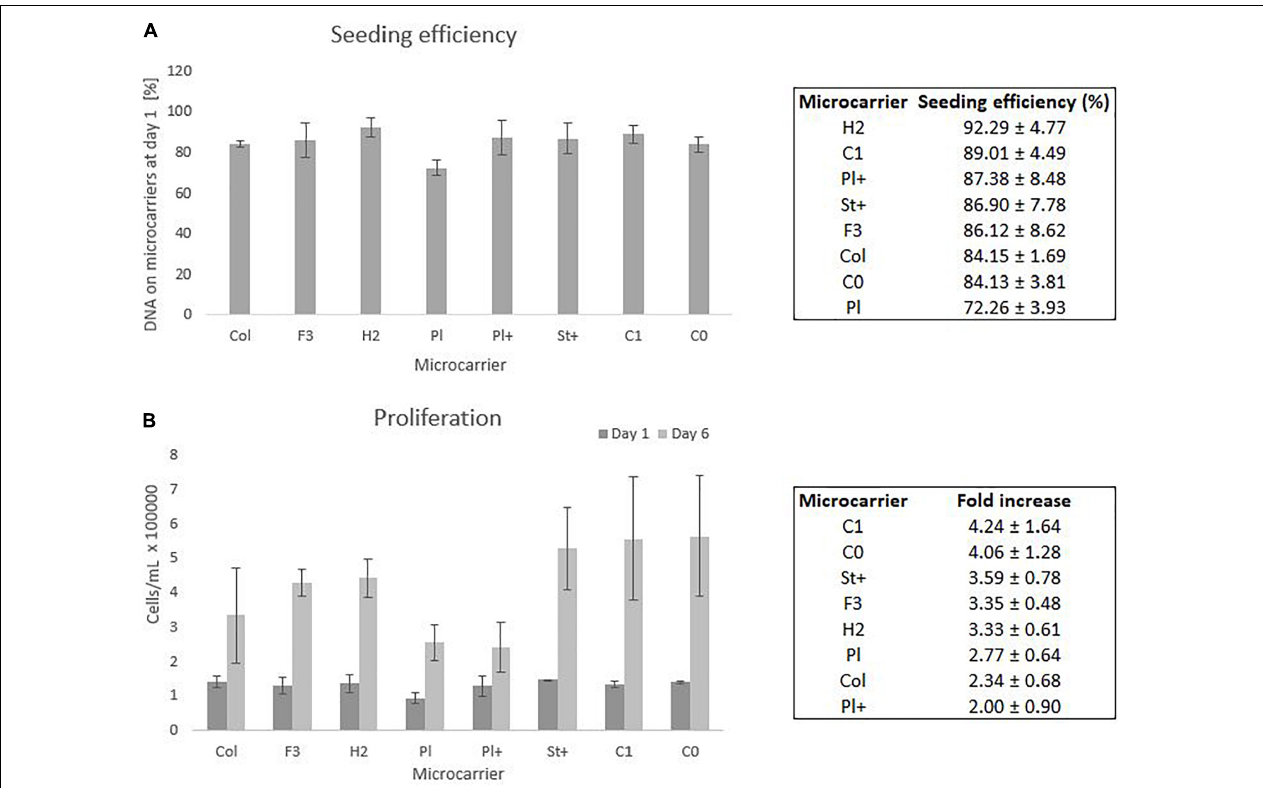
FIGURE 4 | Static screening experiments of the microcarriers Collagen, FACTIII, HillexII, Plastic, Plastic-Plus, Star-Plus, Cytodex-1, Corning untreated. (A) The seeding efficiency is presented as the amount of DNA attached to the microcarriers after 24 h compared to the time of seeding. (B) The proliferation capacity of the cells is visualized as the amount of cells on day 1 compared to day 6. These cell counts are based on DNA calculations converted to cell